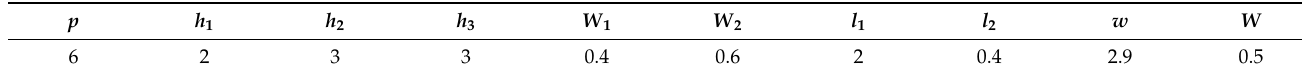
Figure 4. Structure diagram of metasurface element. Table 1. Size of metasurface unit.